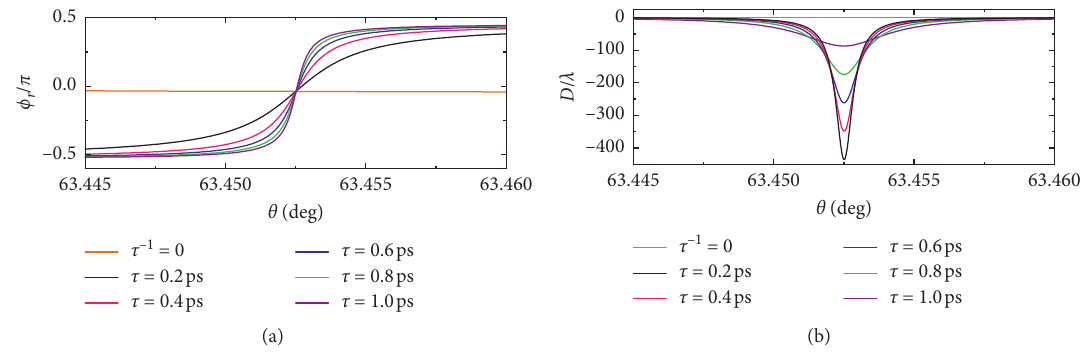
Figure 3: Relationship between the reflection phase, GH shift, and incident angle at different relaxation times.